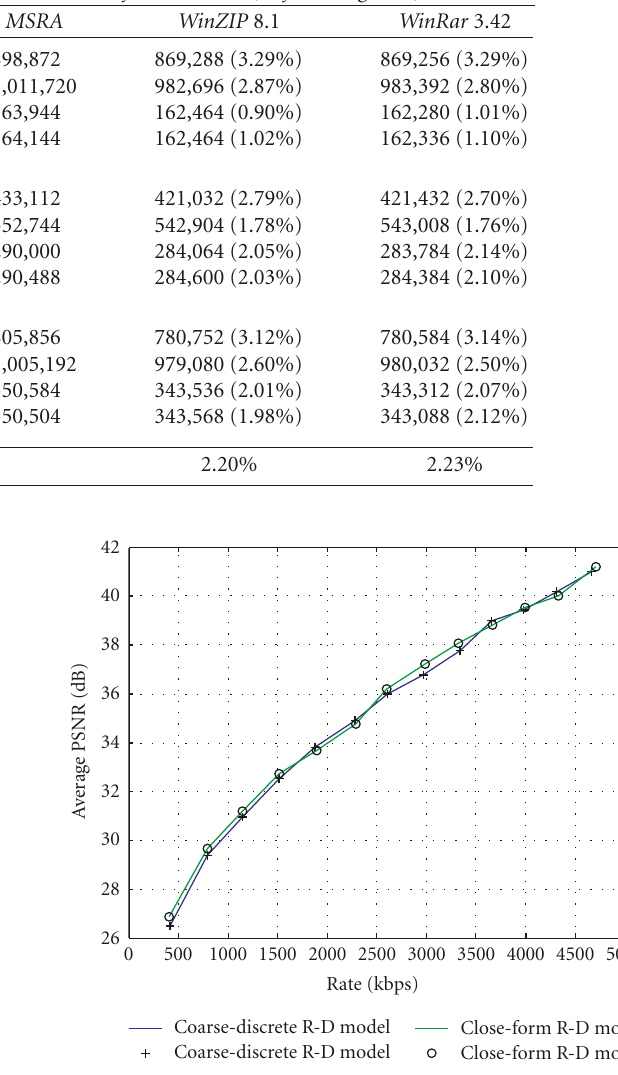
Figure 11: Content-adaptive FEC test for the Stefan sequence (5% losses).